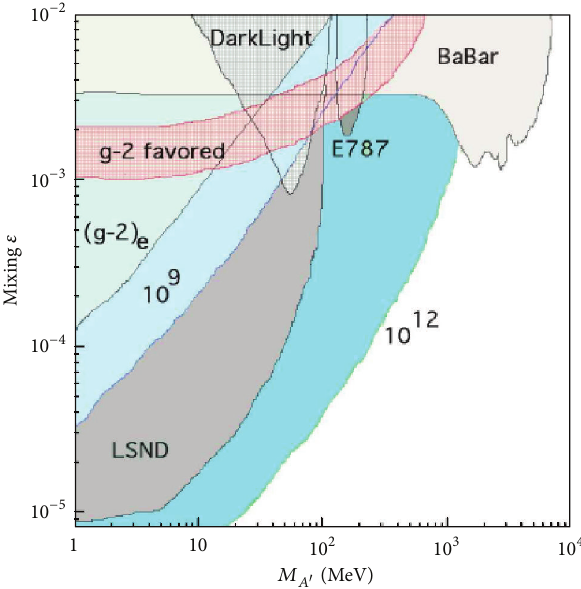
Figure 1: Exclusion region in ( 𝑀 𝐴 󸀠 ; 𝜖 ) plane for invisibly decaying 𝐴 󸀠 into a pair of light dark matter particles 𝜒𝜒 , provided 𝑀